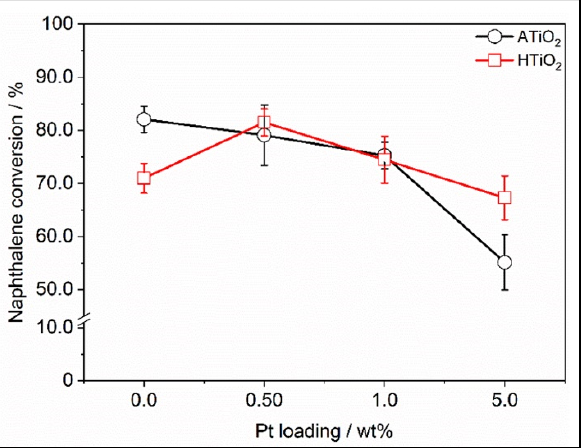
Figure 17. Naphthalene conversion in the presence of TiO 2 -based photocatalysts loaded with different % of Pt nanoparticles. Reprinted with permission from reference [167].